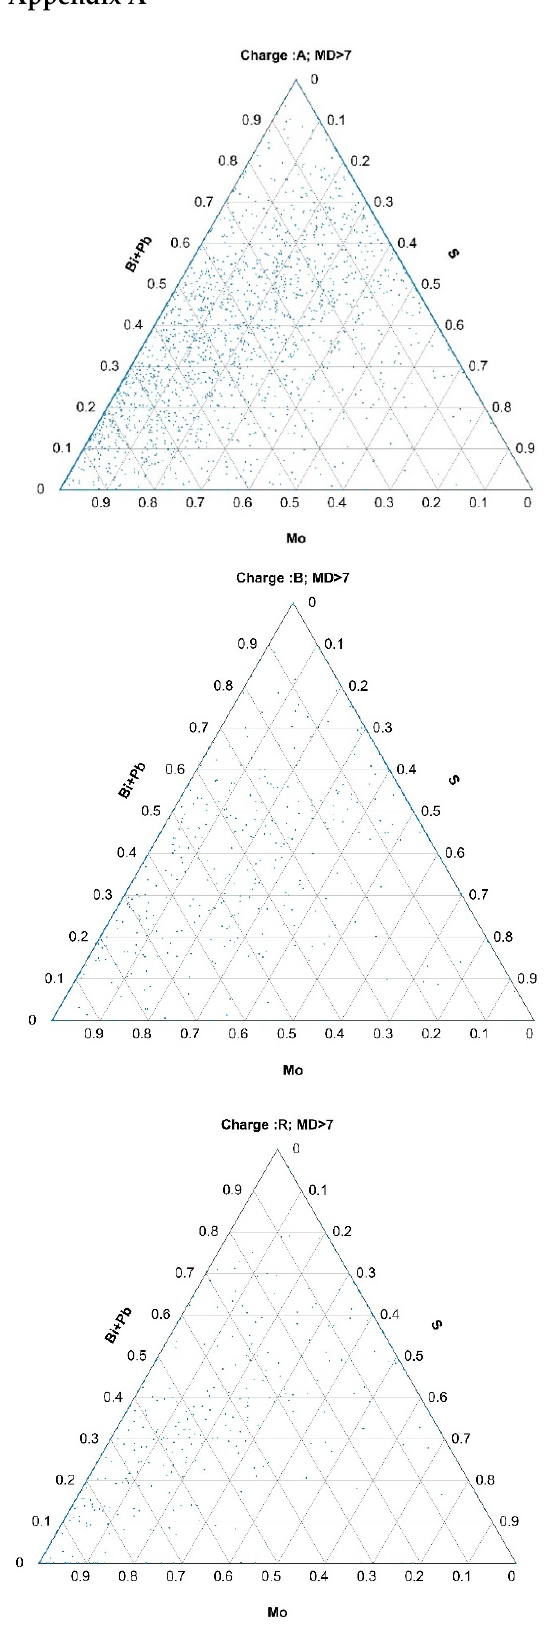
Figure A1. Inclusions classified as outlying (MD > 7) represented in a ternary diagram of Mo, S, and Bi+Pb for charges A, B, and R.